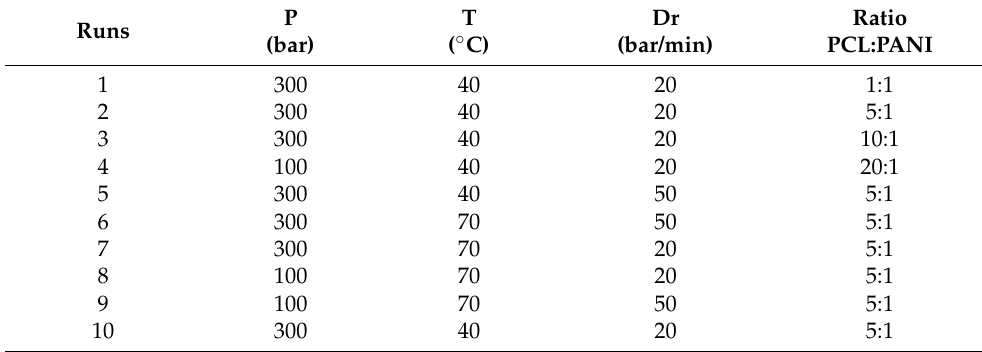
Table 1. Supercritical foaming